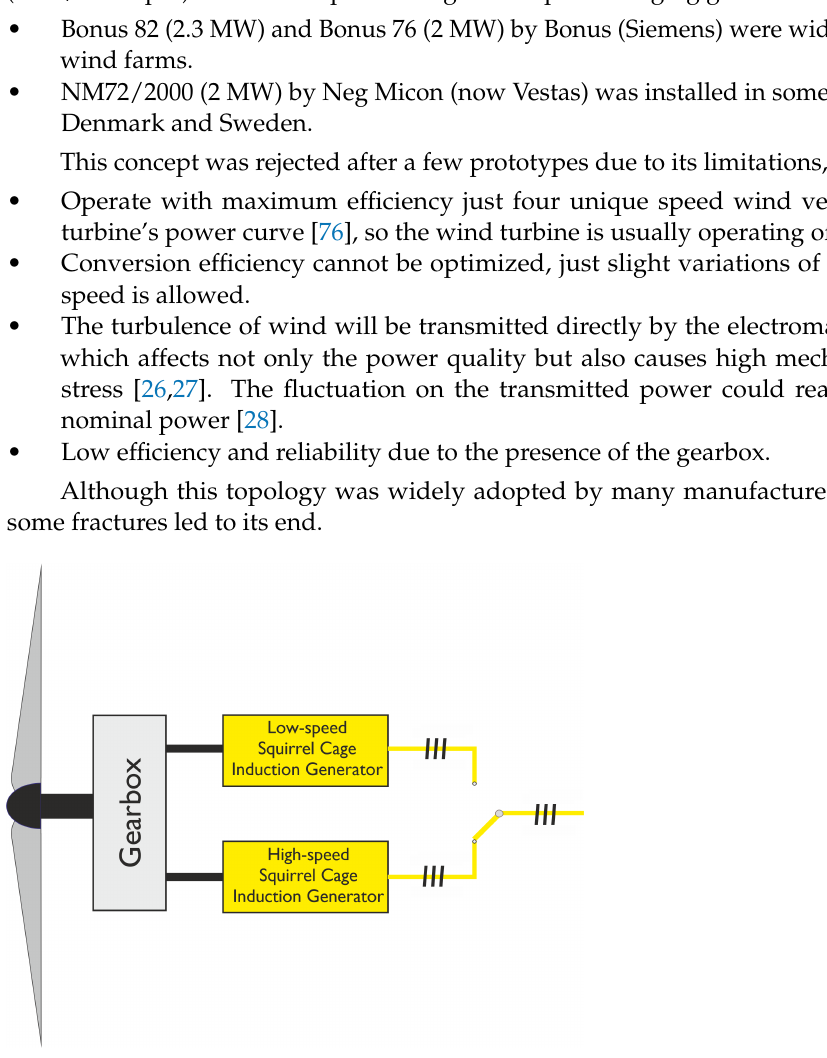
Figure 9. Block diagram of dual-speed wind turbine